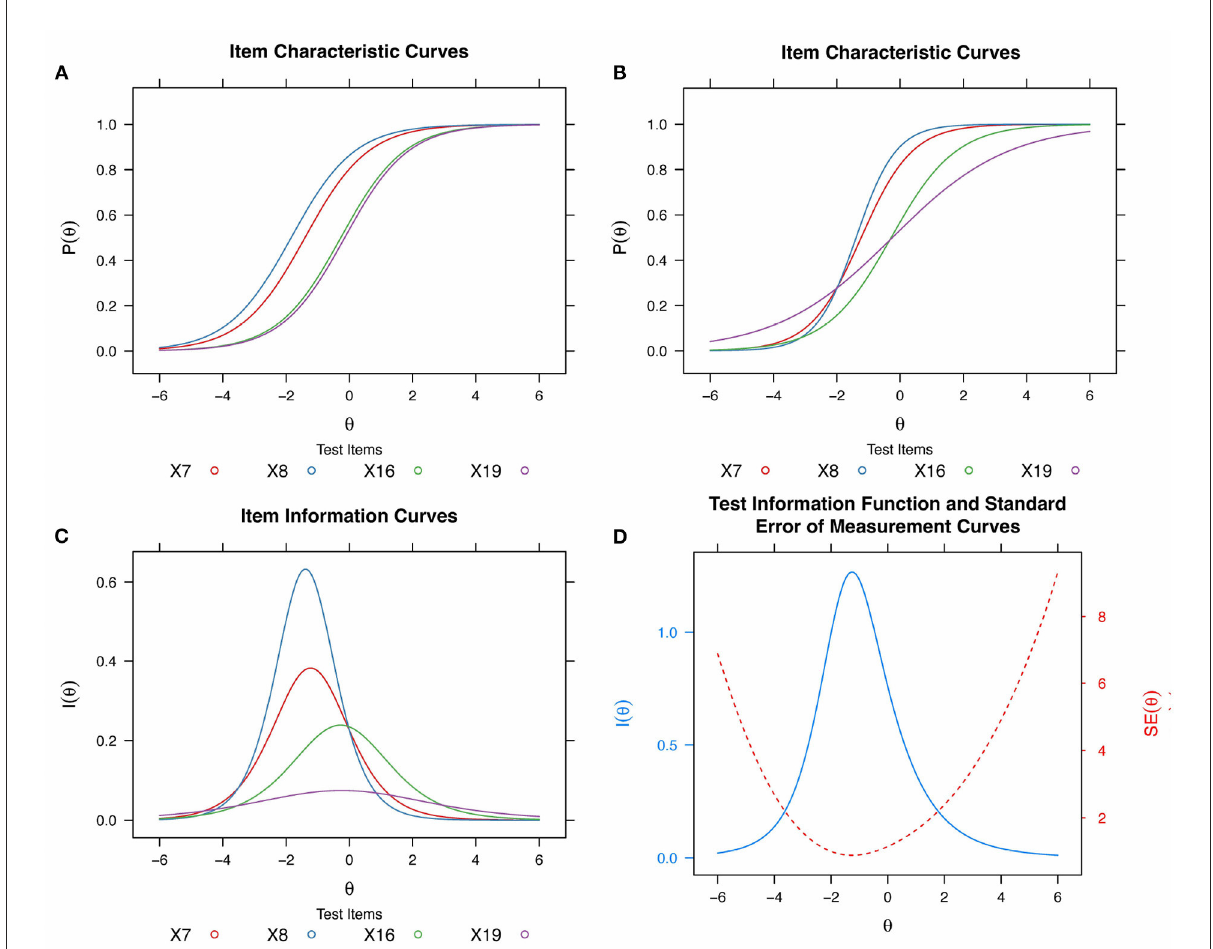
FIGURE2 IRT Theory plots. (A) Item Characteristic Curves for four items of equal discrimination (slope) and varying difficulty (using a 1-PL model on the cCTt test data). (B) Item Characteristic Curves (ICC) for four items (blue, red, green, purple) of varying difficulty and discrimination (using a 2-PL model on cCTt test data). (C) Item Information Curves (IICs) for the items in (B) . (D) Test Information Function (TIF, in blue) for the four items from Panels (B) and (C) (IIC, in black), and the standard error of measurement (SEM, in